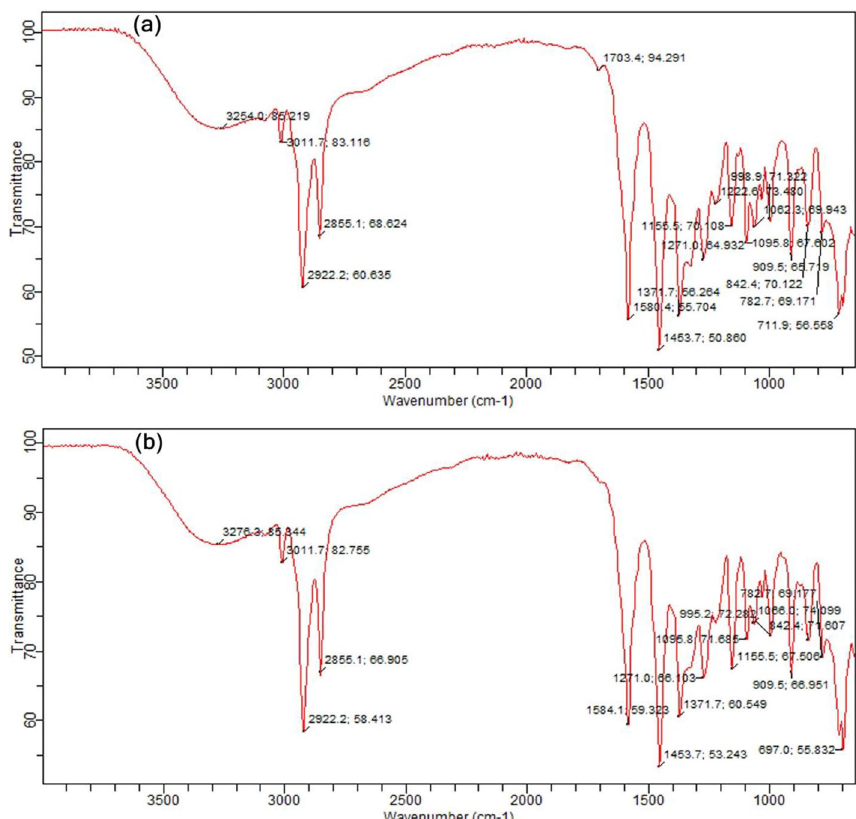
Fig. 3 FTIR spectra of cashew nutshell liquid-triethanolamine derivatives